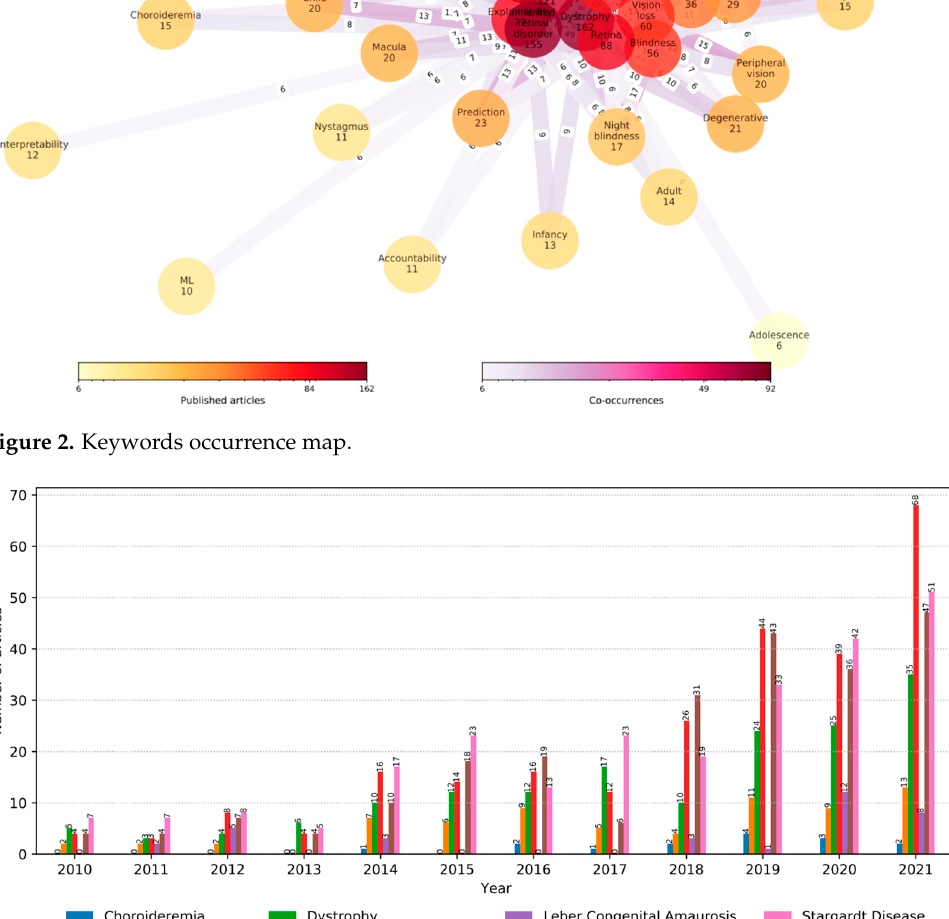
Figure 3. Distribution of diseases according to years.